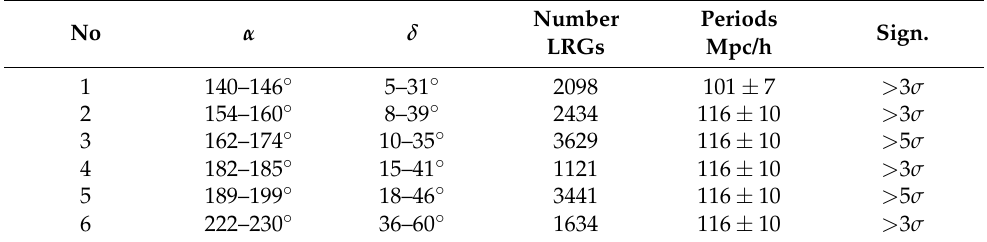
Table 2. Data on six selected sectors with relatively high significance (Sign.) of the peaks in radial power